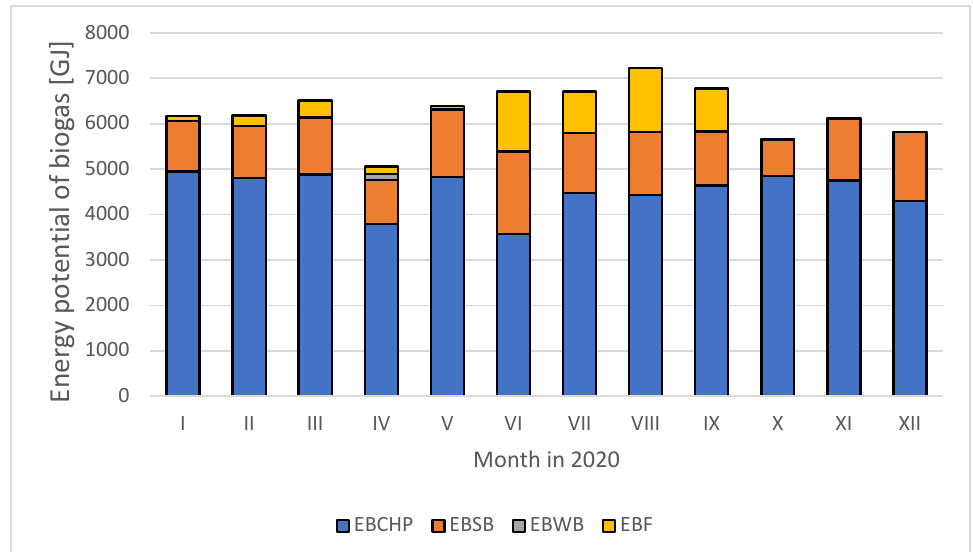
Figure 3. Energy potential of biogas used in individual energy facilities–CHP units (E BCHP ), steam boiler (E BSB ), water boiler (E BWB ) and biogas flare (E BF ) [GJ].